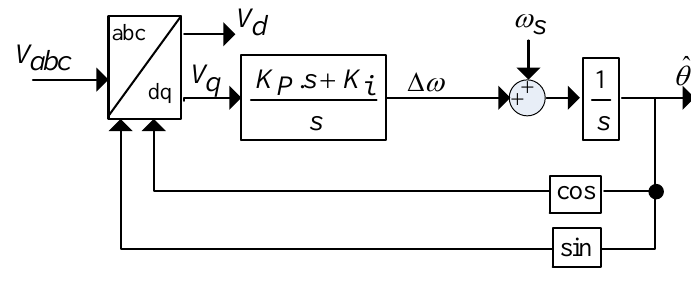
Figure 4. Block diagram of the used Phase Locked Loop.